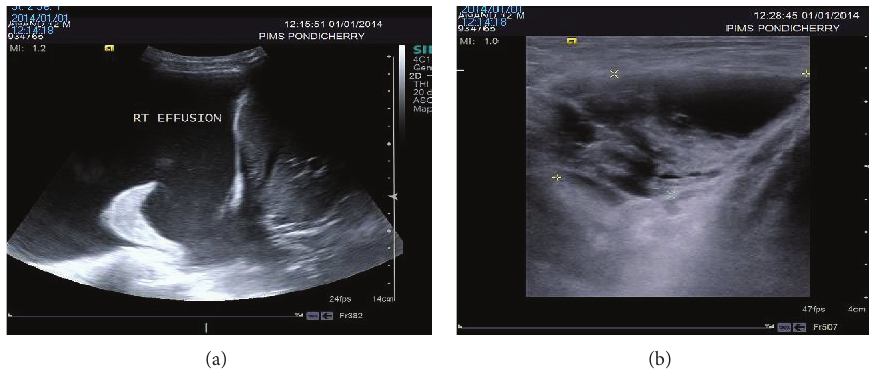
Figure 3: (a) Ultrasound examination of right lower chest showing right pleural effusion. (b) Ultrasound examination of soft tissue swelling in right axilla showing cystic mass with thick and thin septae due to